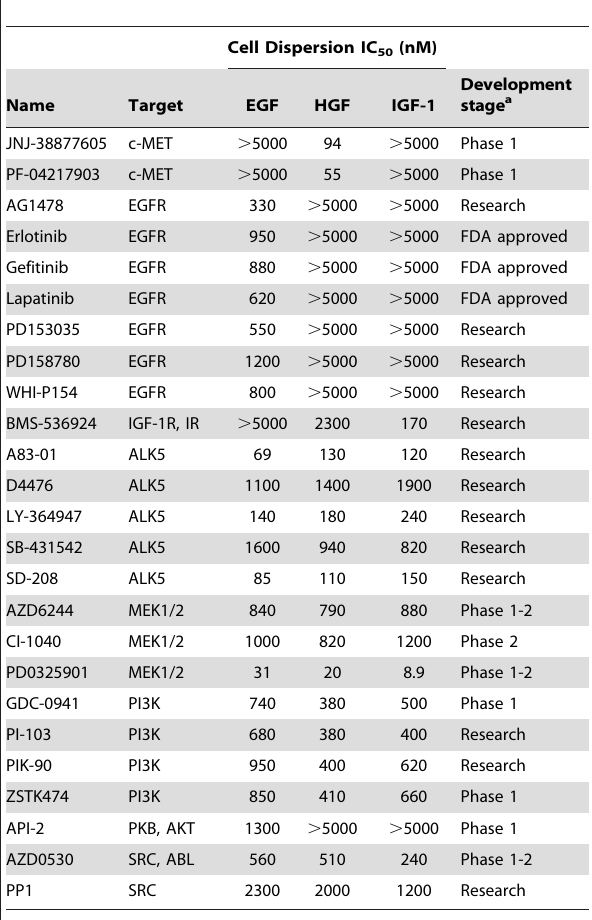
Table 1. Summary of EMT inhibitor CDR IC 50 values against EGF-, HGF- and IGF-1-induced